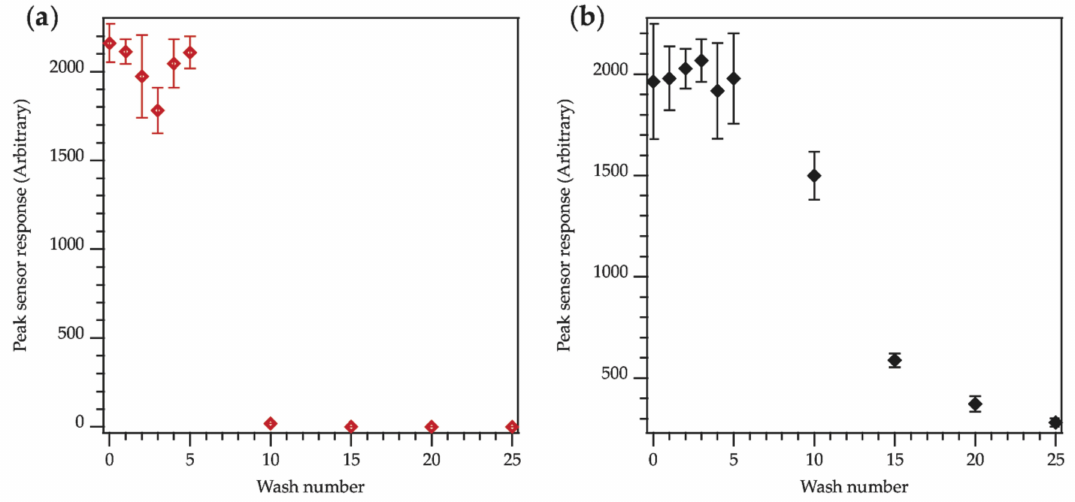
Figure 12. Two example datasets showing the sensor response of the acoustic sensing E-yarns over 25 washes: ( a ) The acoustic sensing E-yarn suddenly stopped working. ( b ) The performance of the acoustic sensing E-yarn degraded with multiple